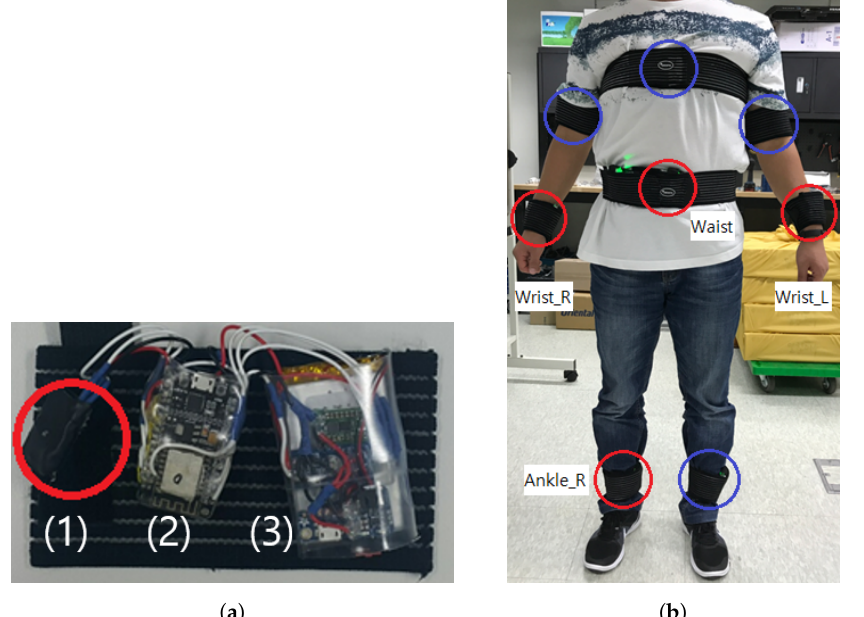
Figure 1. Testbed configuration. ( a ) A body-worn Inertial Measurement Unit (IMU) device consists of (1) a 9-axis IMU sensor (i.e., 3-axis accelerometer, gyroscope, and magnetometer, respectively), (2) a Micro Controller Unit (MCU), and (3) a micro-USB rechargeable Li-Po battery module; ( b ) Among eight body-worn sensors (in circles), only four sensors at left and right wrists, waist, and ankle (in red circles) are adopted for the data analysis.